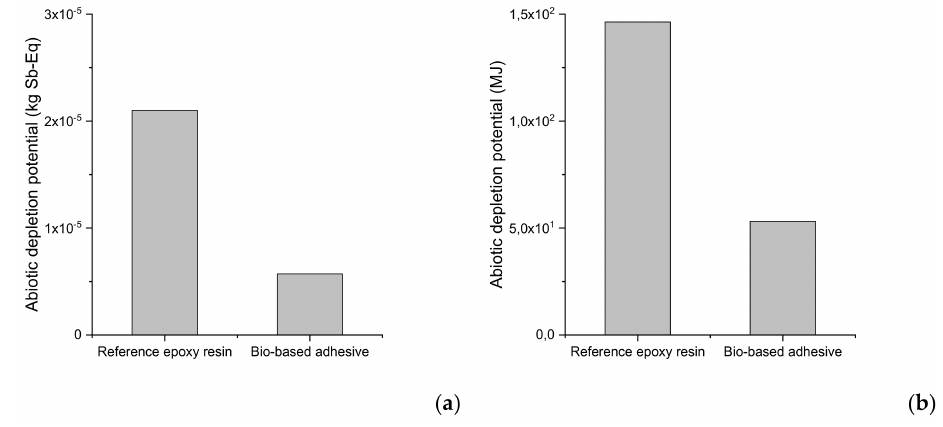
Figure 1. Comparison of ADP ( a ) kg-Sb-Eq, ( b ) MJ.